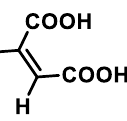
1 H NMR (400 MHz, DMSO-d